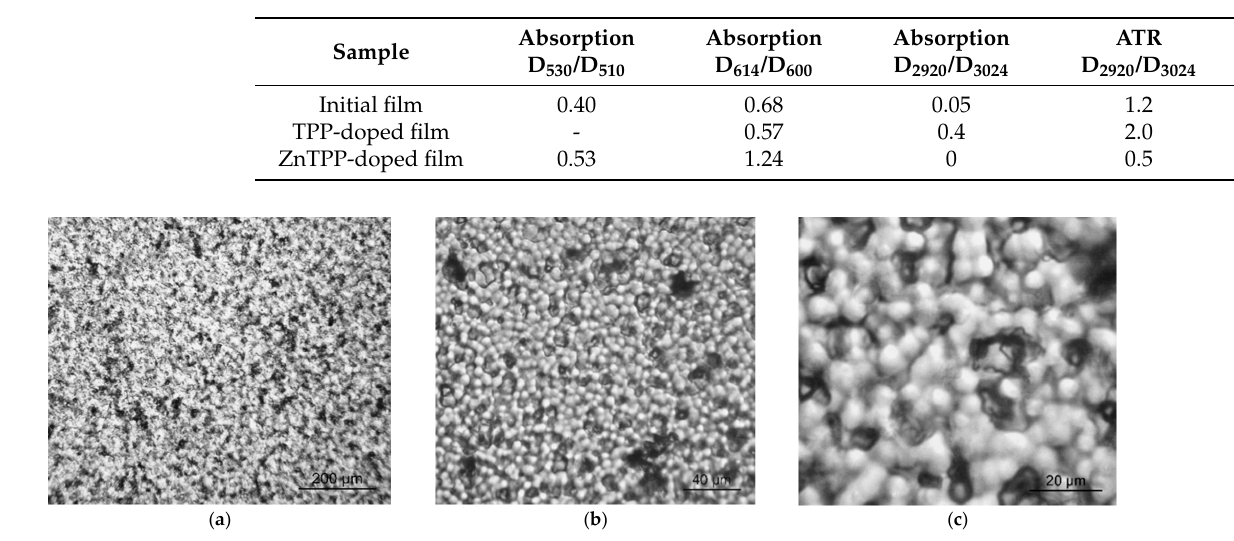
Table 2. Intensity ratio of a number of bands in the IR spectra of doped P(VDF-HFP) copolymer films crystallized from acetone.